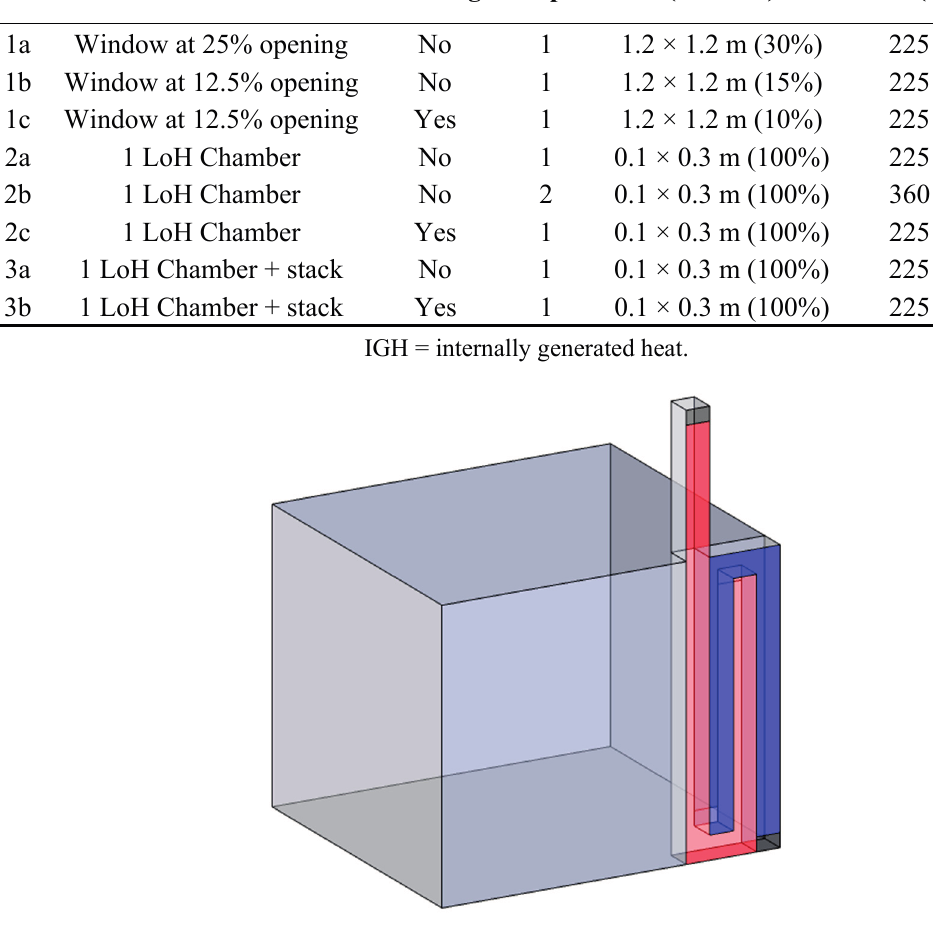
Figure 4. The modified LoH Chamber with extended stack used in Cases 3a and